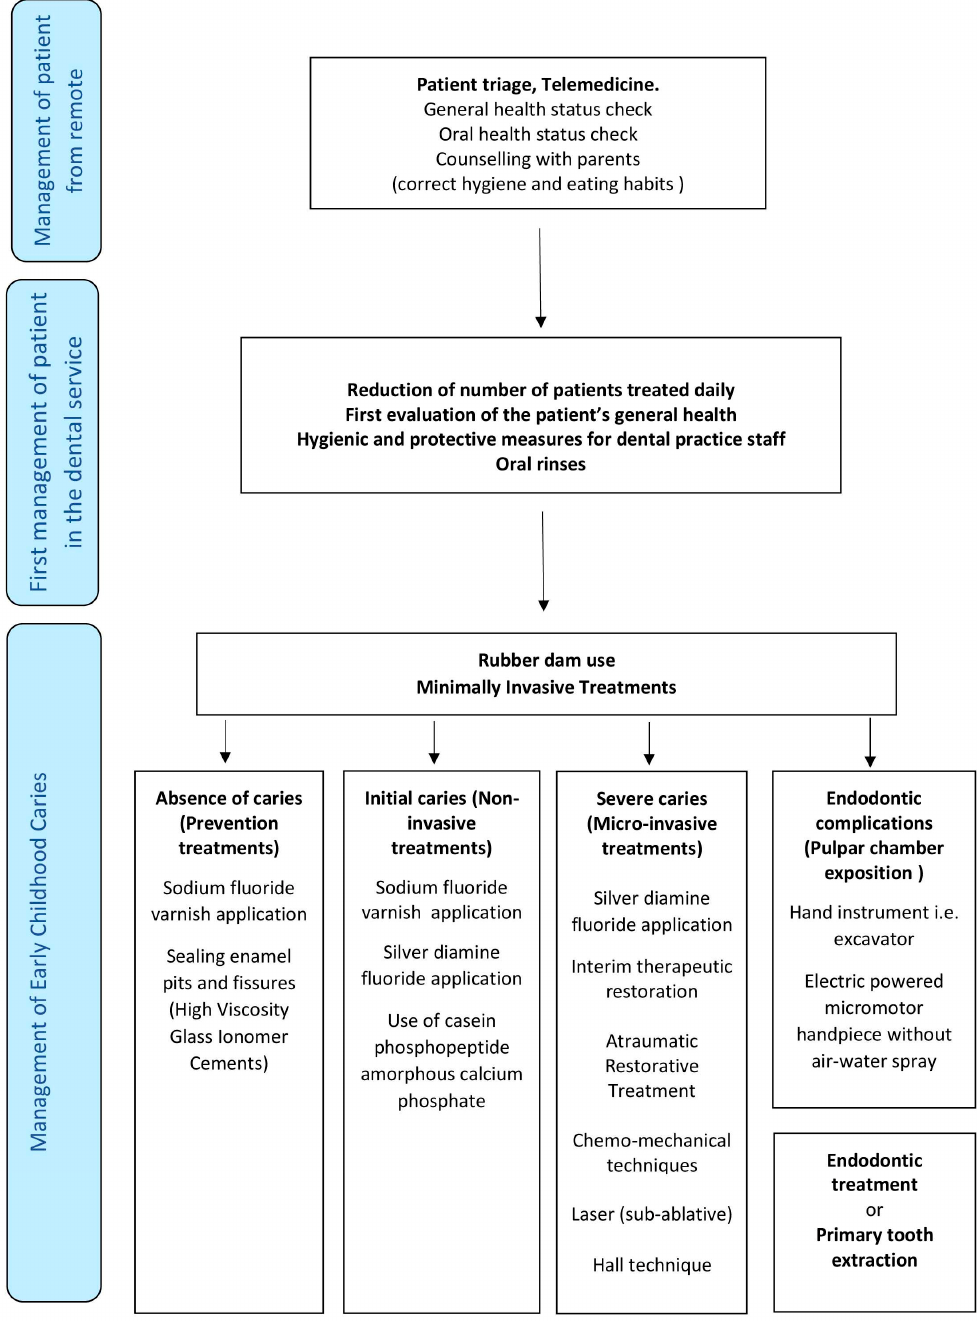
Figure 1. Flow Diagram describing the hierarchy of the procedures for the correct management of patients affected by Early Childhood Caries (ECC) during the SARS CoV-19 epidemic.